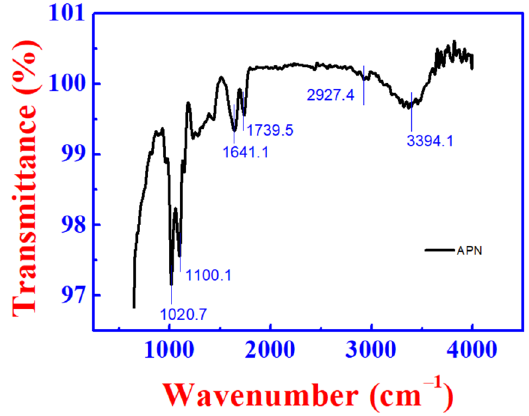
Figure 2. FTIR spectrum of the APN thin film.